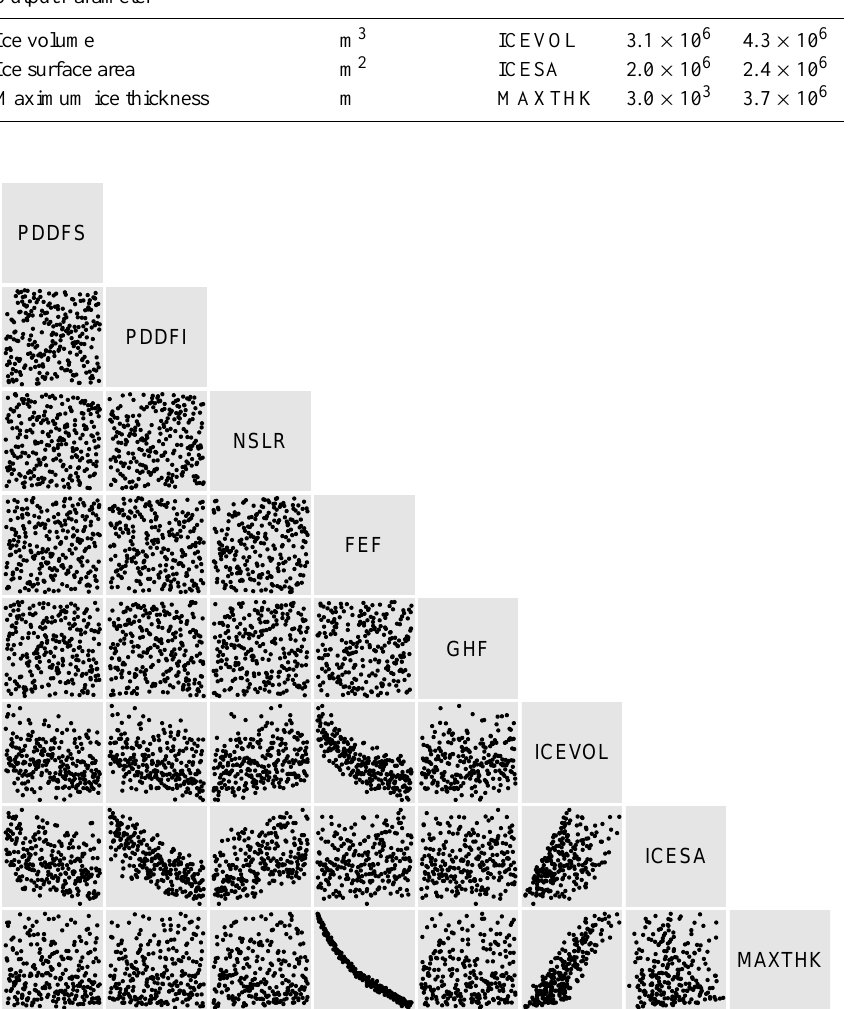
Table 1. Expert-elicited ranges for input parameters of Glimmer, and the corresponding ranges of the output parameters. Units Abbrev. Min Max Input Parameter Positive degree day factor for snow mmd − 1 ◦ C − 1 PDDFS 3 5 Positive degree day factor for ice mmd − 1 ◦ C − 1 PDDFI 8 20 Near-surface lapse rate ◦ Ckm − 1 NSLR − 8 . 2 − 4 Flow enhancement factor – FEF 1 5 Geothermal heat flux mWm − 2 GHF − 61 − 38 Output Parameter Ice volume m 3 ICEVOL 3 . 1 × 10 6 4 . 3 × 10 6 Ice surface area m 2 ICESA 2 . 0 × 10 6 2 . 4 × 10 6 Maximum ice thickness m MAXTHK 3 . 0 × 10 3 3 . 7 × 10 6